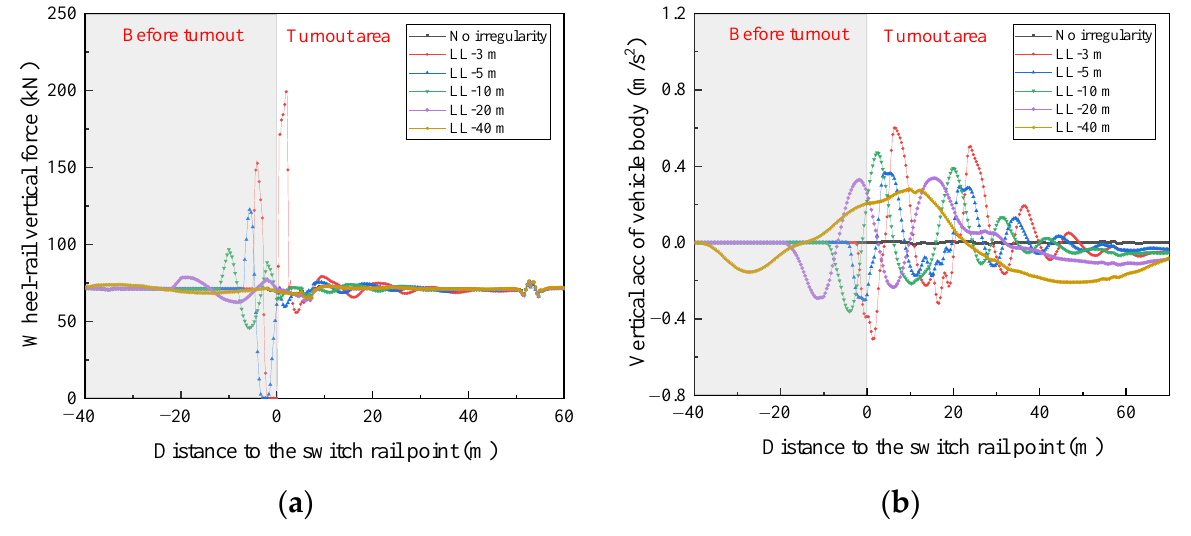
Figure 14. Variations along the distance in the dynamic indicators under the LL in front of the turnout: ( a ) Wheel-rail vertical force; ( b ) Vertical acceleration of the vehicle body. Figure 15 shows the time-frequency diagrams of the wheel-rail vertical force and vertical acceleration of the vehicle body under the LL in front of the turnout at wavelengths of 3 m and 40 m. The LL at the wavelength of 3 m in front of the turnout has a much greater effect on the wheel-rail vertical force and the vertical acceleration of the vehicle body than the irregularity at the wavelength of 40 m. Under the effect of the LL at the wavelength of 3 m, the wheel-rail vertical force presents a high-frequency response at the extremes, while the vertical acceleration of the vehicle body has a large response until 40 m away from the switch rail point, and the frequency effect is concentrated below 20 Hz.